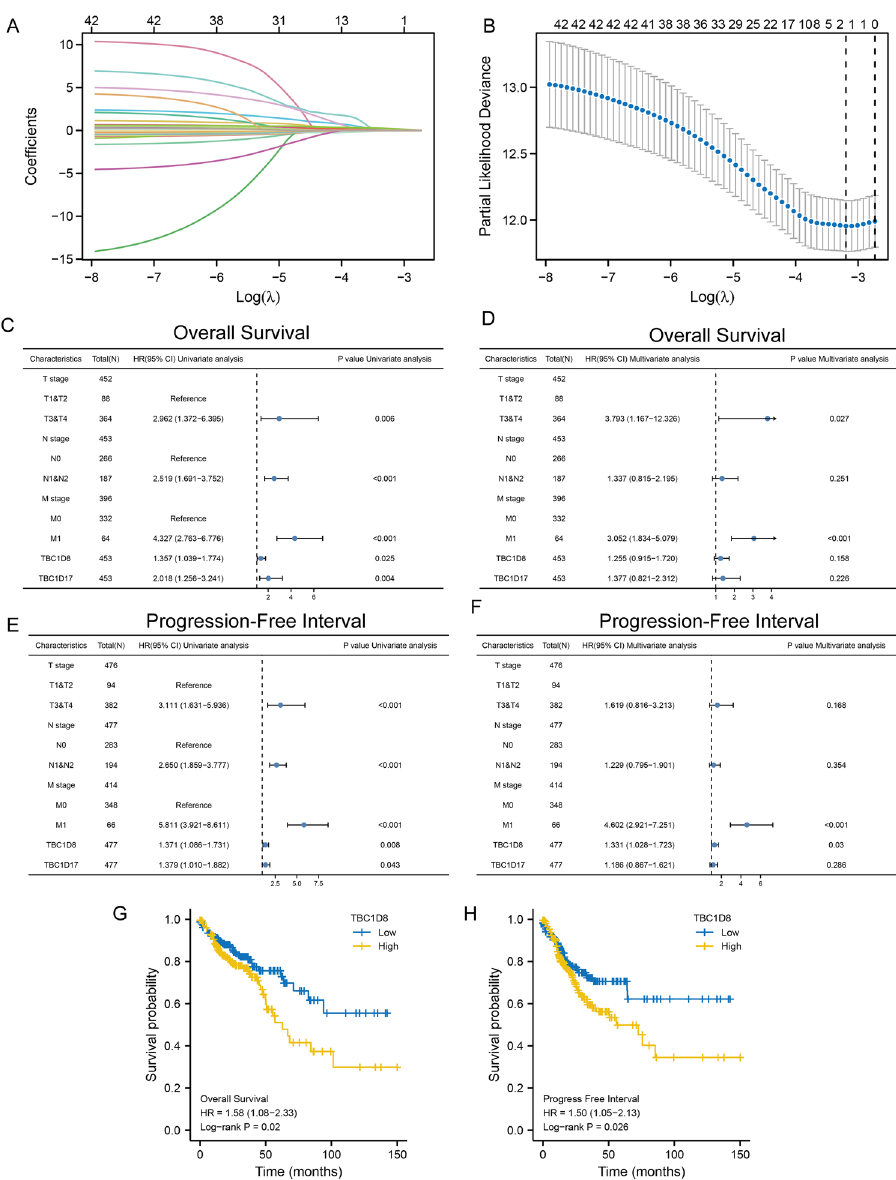
Figure 1. TBC1D8 expression as an indicator of overall survival and progression-free interval determined by Least absolute shrinkage and selection operator (LASSO) and Cox regression analysis in the The Cancer Genome Atlas (TCGA) cohort. ( A ) In the LASSO-Cox model based on TCGA-Colon Adenocarcinoma (COAD), the minimum standard was adopted to obtain the value of the super parameter λ by tenfold cross- validation, where the optimal lambda resulted in 2 non-zero coefficients (n = 480). ( B ) Cross-validation for selecting tuning parameters. ( C – F ) Univariate ( C , E ) and multivariate ( D , F ) Cox regression analysis for overall survival ( C , D ) and progression free interval ( E , F ) of the relationship between TBC1D8 and TBC1D17 levels and clinicopathological parameters related to CRC prognosis in TCGA-COAD (n = 480). ( G , H ) Overall survival (OS) ( G ), Disease-specific survival (DSS) ( H ), and Progression-free interval (PFI) ( I ) based on median TBC1D8 levels in TCGA-COAD (n =